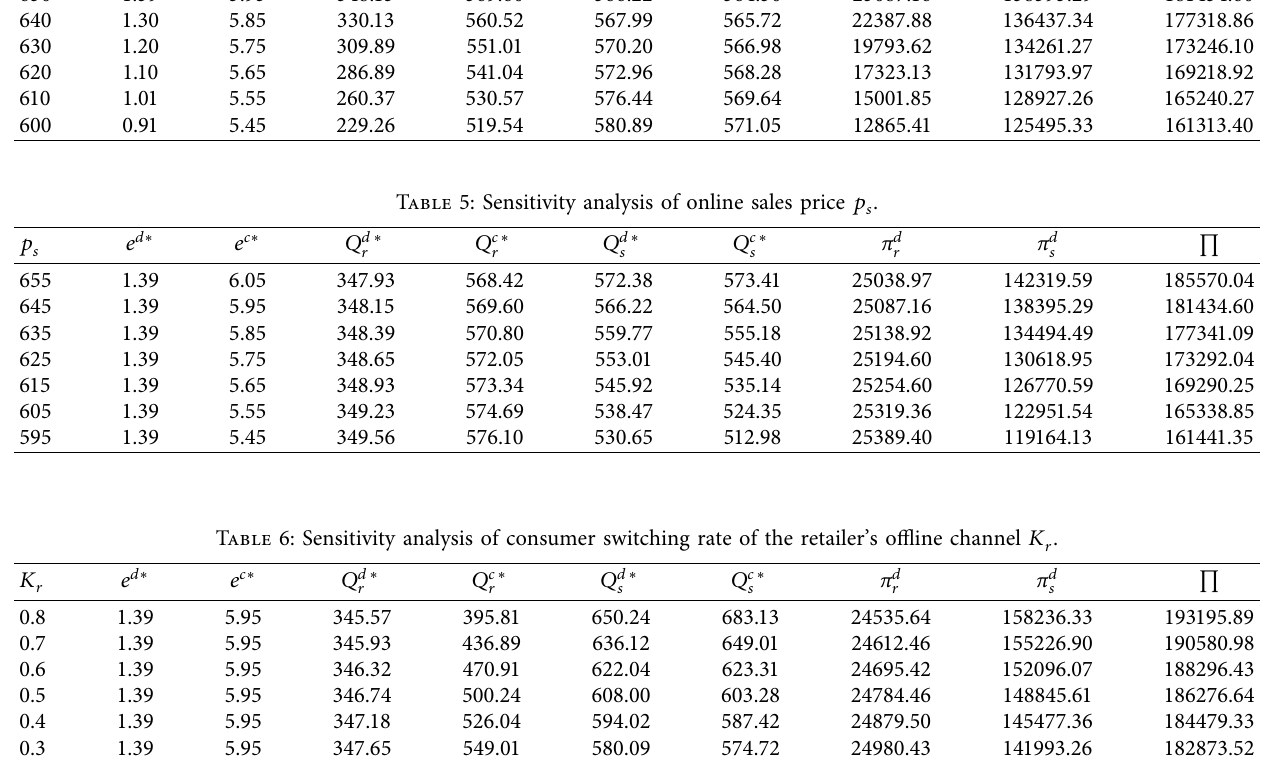
Table 7: Sensitivity analysis of consumer switching rate of the supplier’s online channel K